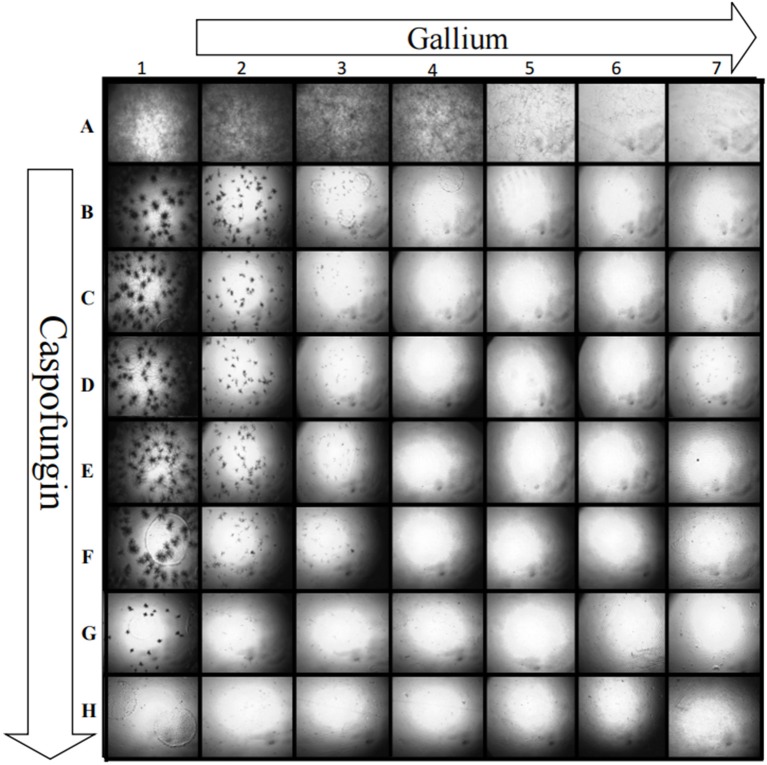
Growth of A. fumigatus CEA10 in checkerboard assay showing that when gallium (row) is combined with caspofungin (column), there is a visible decrease in the hyphae growth compared to the single drug challenge (column A and row 1). Image A1 shows the growth control, without drugs. Increase = 50×.